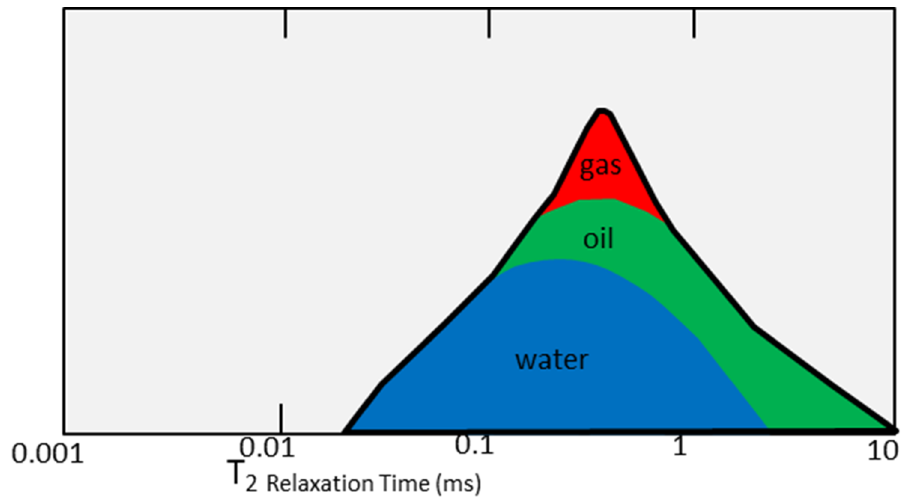
Figure 2. Graphical representation of NMR T 2 distribution of different fluid phases.